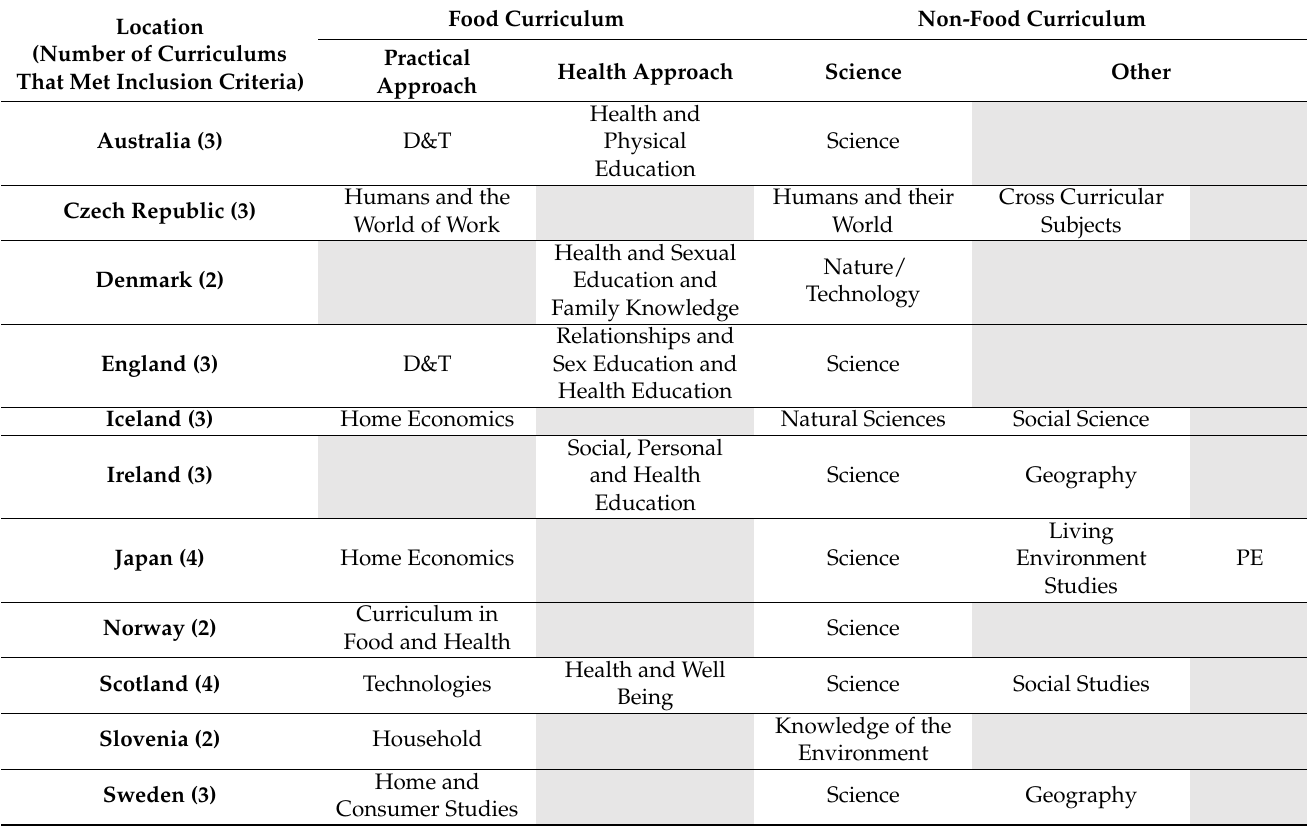
Table 4. Overview of curriculums in each country and province that include food education and what they are called. Grouped into food curriculums, either practical or health approaches and non-food curriculums. Source: